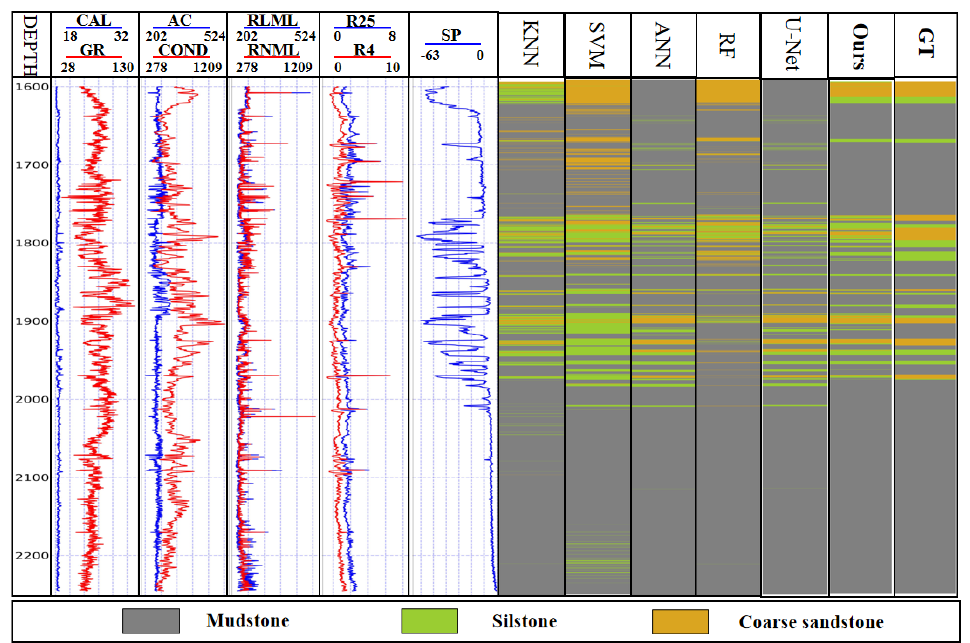
Figure 7. Visualization of experimental data and different methods of lithology identification in well B, where GT stands for “ground truth”, which is a manually produced lithology